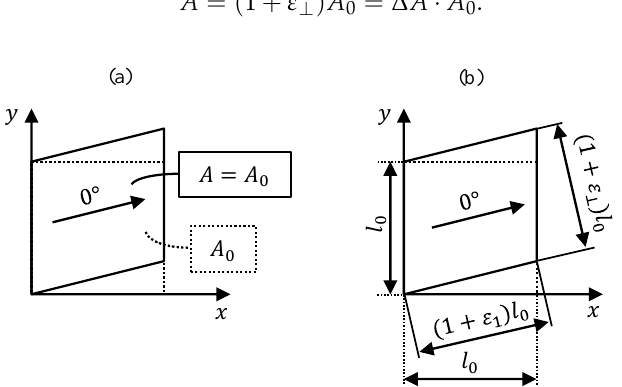
Figure 8. Simple shear deformation caused by roving sliding (e.g., for the wavy pattern) ( a ) and square area change due to this slip-induced deformation ( b ).